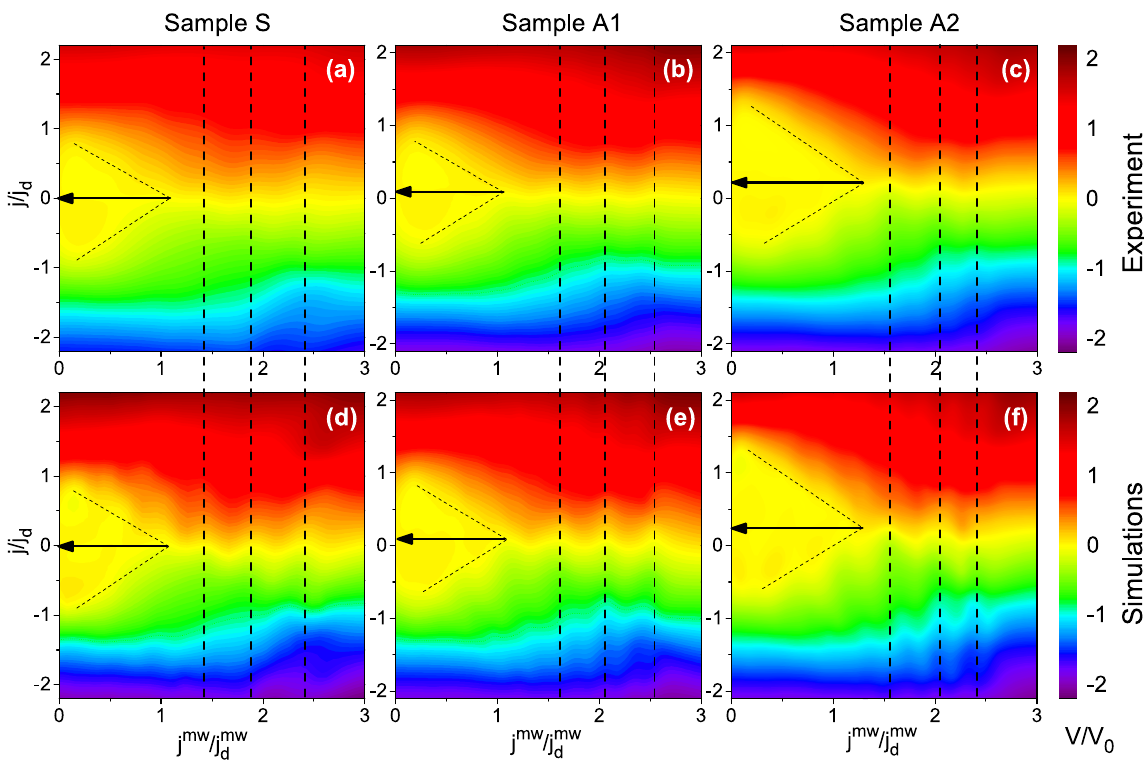
Figure 4. Electrical dc voltage as a function of the normalized dc current density and the microwave amplitude for all samples at T = 0.98 T c and H m = 7.2 mT. ( a – c ) Experimental data. ( d – f ) Theoretical modeling results, as detailed in Discussion. The color scale is the same in all panels with the electrical voltage normalized to the first Shapiro step voltage V 0 . Vertical dashed lines mark mode-locking fringes. Arrows depict the dc loading capability of the vortex ratchets, as deduced from crossing the straight lines j d ( j mw ) at the point where the internal asymmetry of the pinning potential is effectively compensated by the extrinsic asymmetry of the WPP caused by the dc bias.